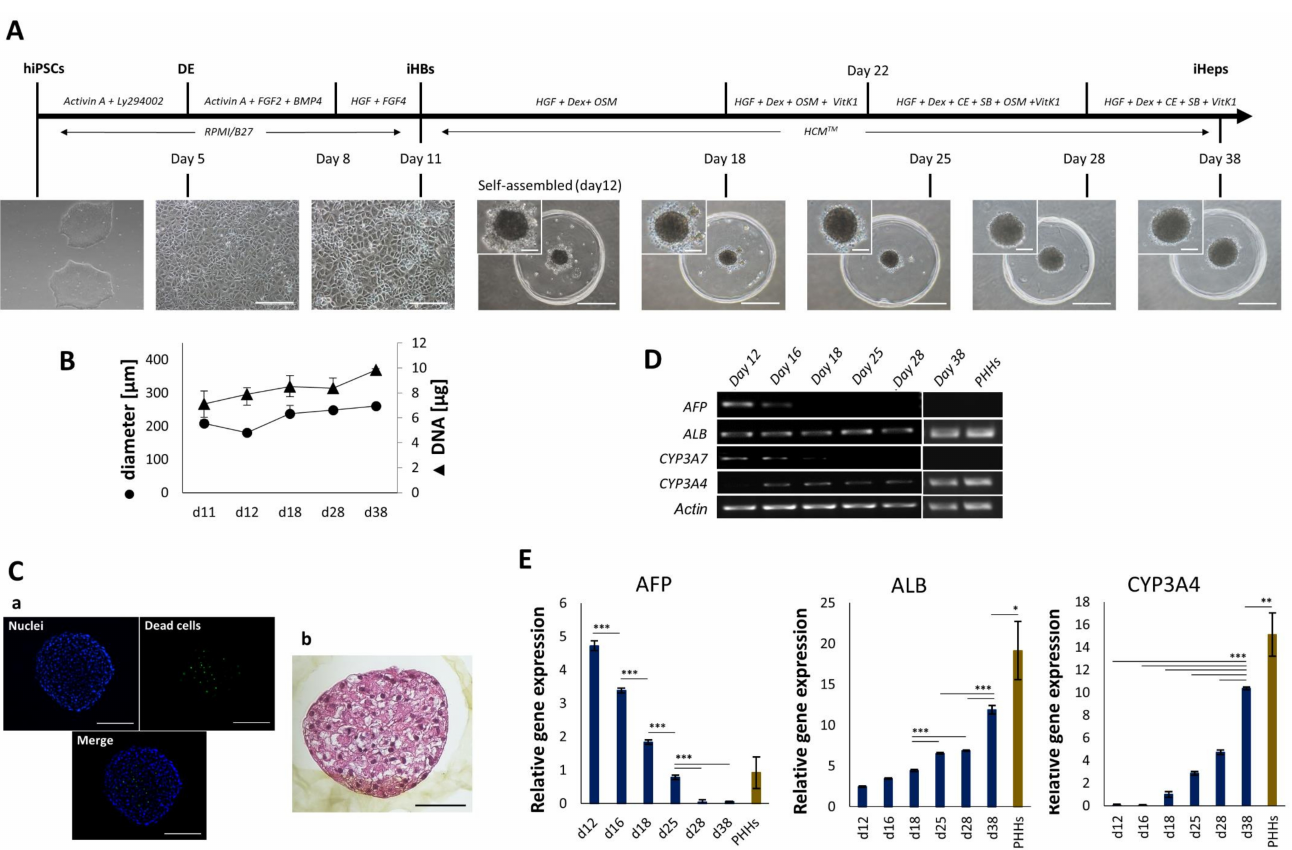
Figure 1. Generation of iHep-Orgs from hiPSCs. ( A ) Schematic representation of the differentiation protocol and brightfield images of undifferentiated hiPSCs, differentiated endoderm (day 5), hep- atoblasts (day 11), and self-organized iHep-Orgs after 24 h of assembling (day 12) and over time (days 18, 25, 28, 38). Scale bars for brightfield images = 100 µ m. Scale bars for iHep-Orgs = 500 µ m. Scale bars for magnifications = 100 µ m. ( B ) Evolution of diameter and DNA content of iHep-Orgs over time (measures carried out on 35 and 200 organoids, respectively). Graph represents mean values ± SD ( n = 16). ( Ca ) Viability assay of iHep-Orgs at day 38 of differentiation. Alive cells’ nuclei are stained in blue; dead cells’ nuclei are stained in green. Scale bars = 100 µ m. Images are the Z-projections obtained by combining multiple images taken at different focal distances (z-stacking); ( Cb ) H&E staining on section of a representative iHep-Org. Scale bar = 100 µ m. ( D ) RT-PCR analysis of AFP, ALB, CYP3A7, and CYP3A4 gene expression in iHep-Orgs over time and PHH-Orgs at day 8 of culture. ( E ) AFP, ALB, and CYP3A4 gene expression in iHep-Orgs over time (blue bars). PHHs have been used as control (brown bars). Quantification is relative to the expression level in fetal human hepatocytes (GS 20 weeks). Histograms represents mean ± SD ( n = 16). *** indicates p < 0.001; ** indicates p < 0.01; * indicates p <